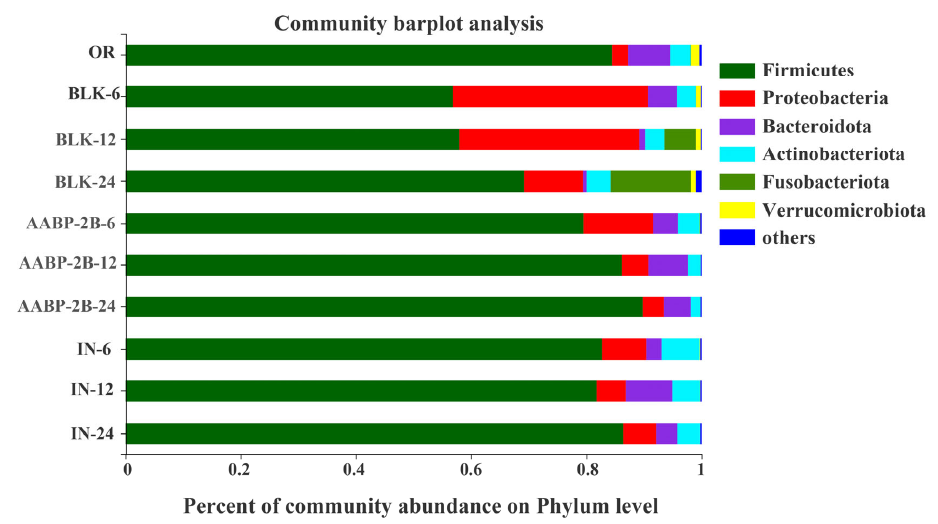
Figure 9. Phylum level distribution of gut microbiota. OR, original faeces group; BLK, without-carbon-source group; AABP-2B, indigestible A. asphodeloides polysaccharide (AABP-2B) = treatment group; IN, inulin-treatment group.